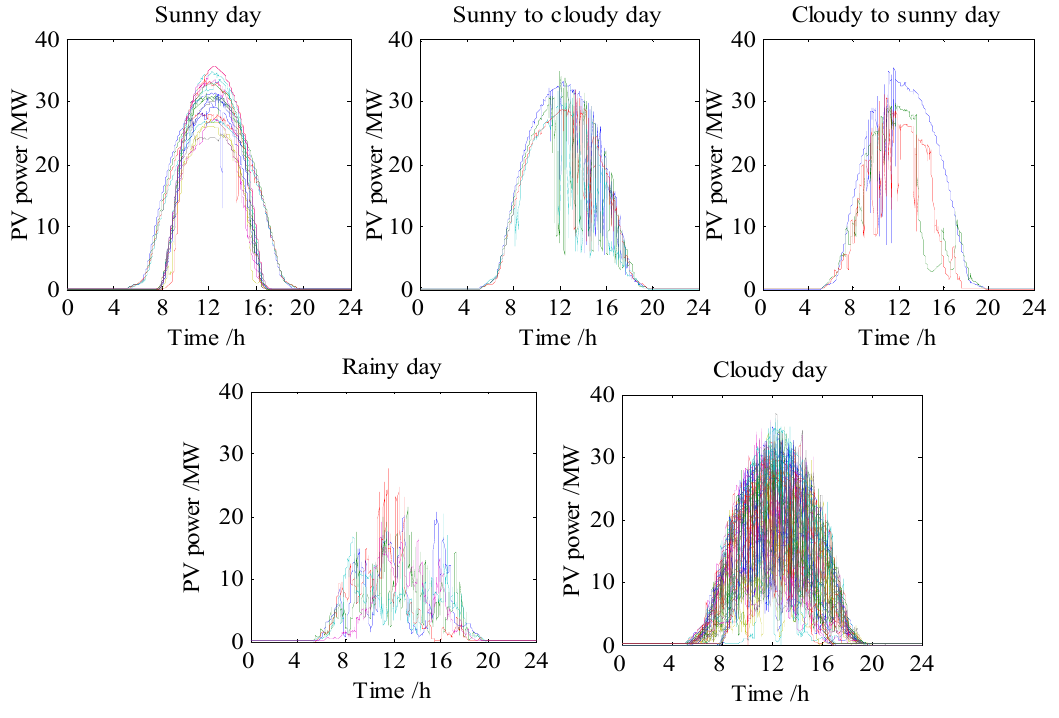
Figure 4. Clustering analysis on PV data based on weather conditions (one part).